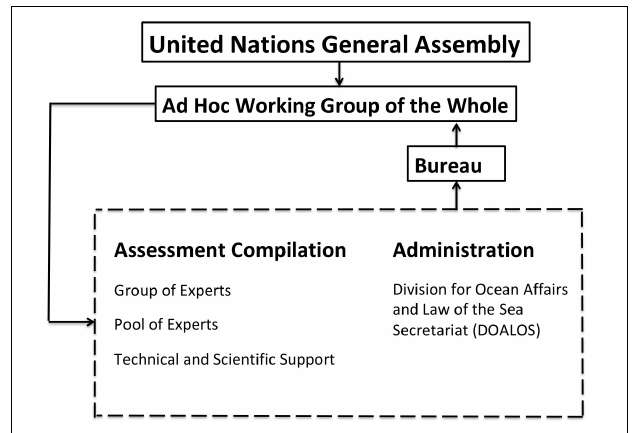
FIGURE 1 | The institutional structure of the Regular